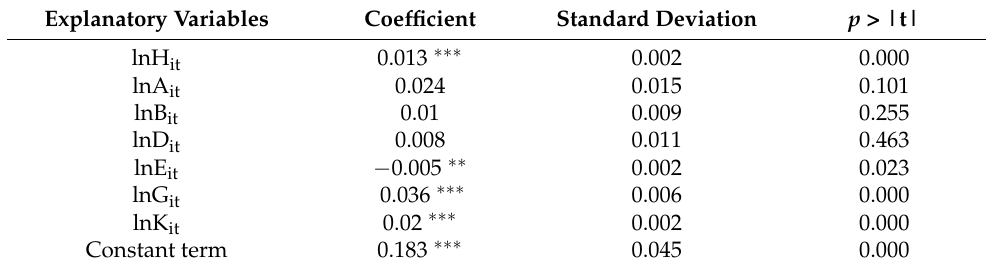
Table 4. Stability